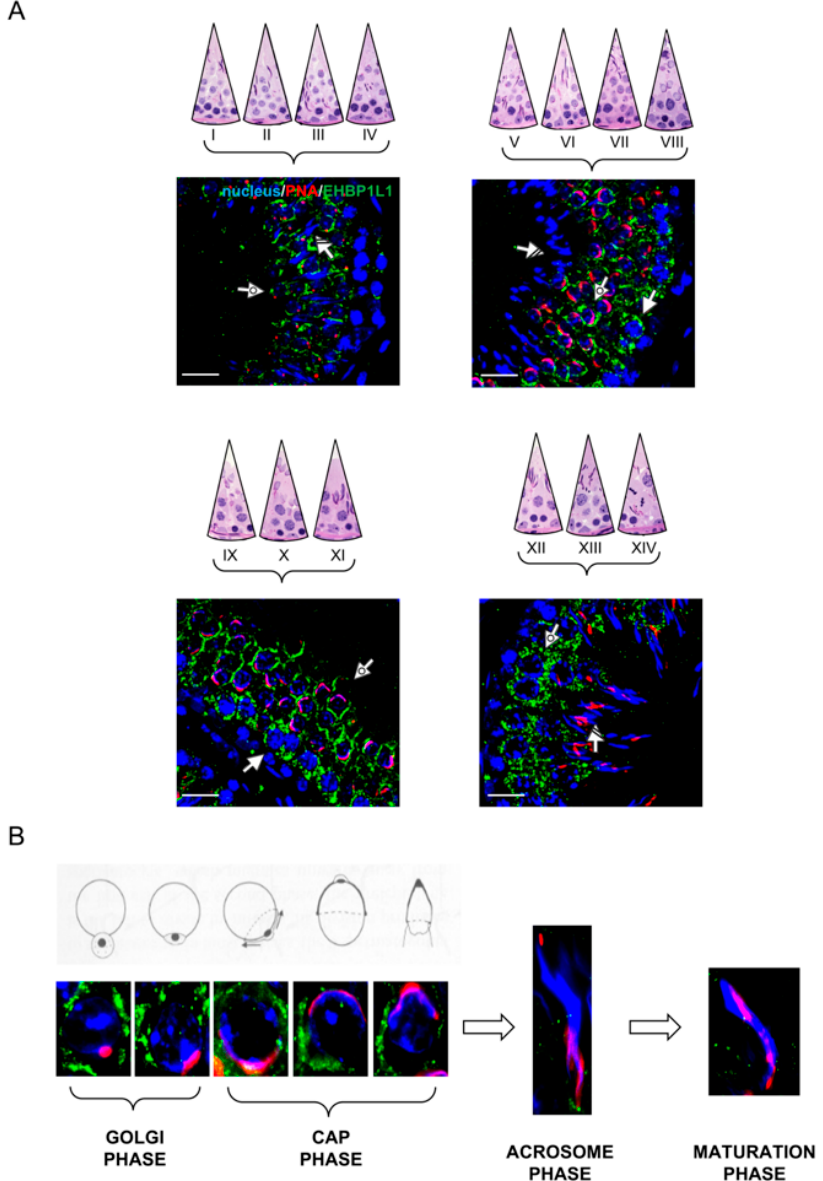
Figure 5. Localization of EHBP1L1 in adult rat testis (60 dpp). ( A ) EHBP1L1 localization in different stages of adult rat spermatogenesis. To better show the differences between them, the 14 stages comprising the whole spermatogenic cycle are arbitrarily sub-divided into four parts. Scale bars represent 20 µ m. Arrow: I SPC; dotted arrow: rSPT; striped arrow: eSTP. ( B ) EHBP1L1 localization in SPT in comparison with a schematic representation of the different phases of acrosome biogenesis. In A and B merged images, the blue channel represents DAPI-fluorescent nuclear staining, the red channel represents PNA lectin acrosome staining, and the green channel represents EHBP1L1 fluorescent signal.